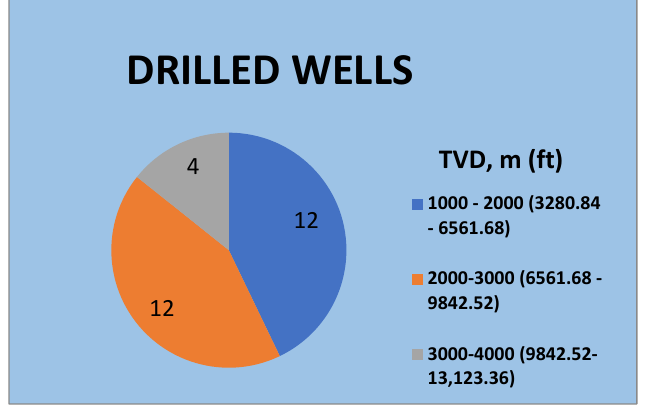
Figure 6. True vertical depth of the analyzed wells.